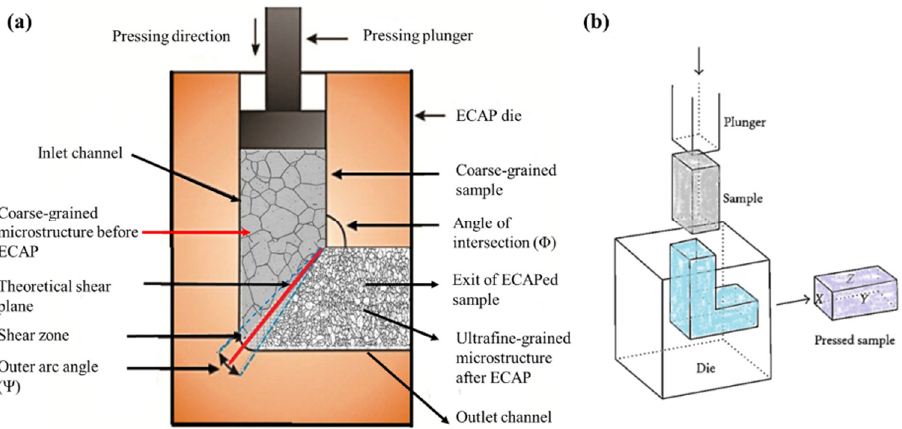
Figure 5. A schematic illustration of the ECAP process: ( a ) the different parts of the ECAP die, channels, angles, and shear zone, and ( b ) the sample passing through the ECAP channels.